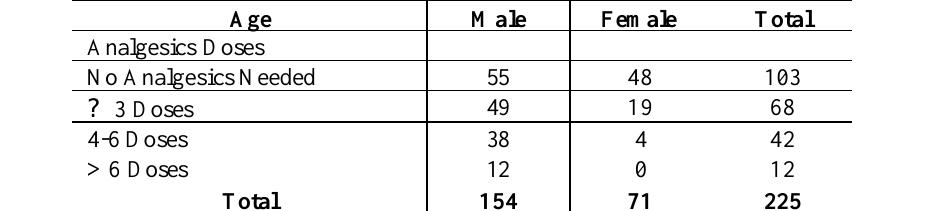
Table III : Postoperative Analgesics